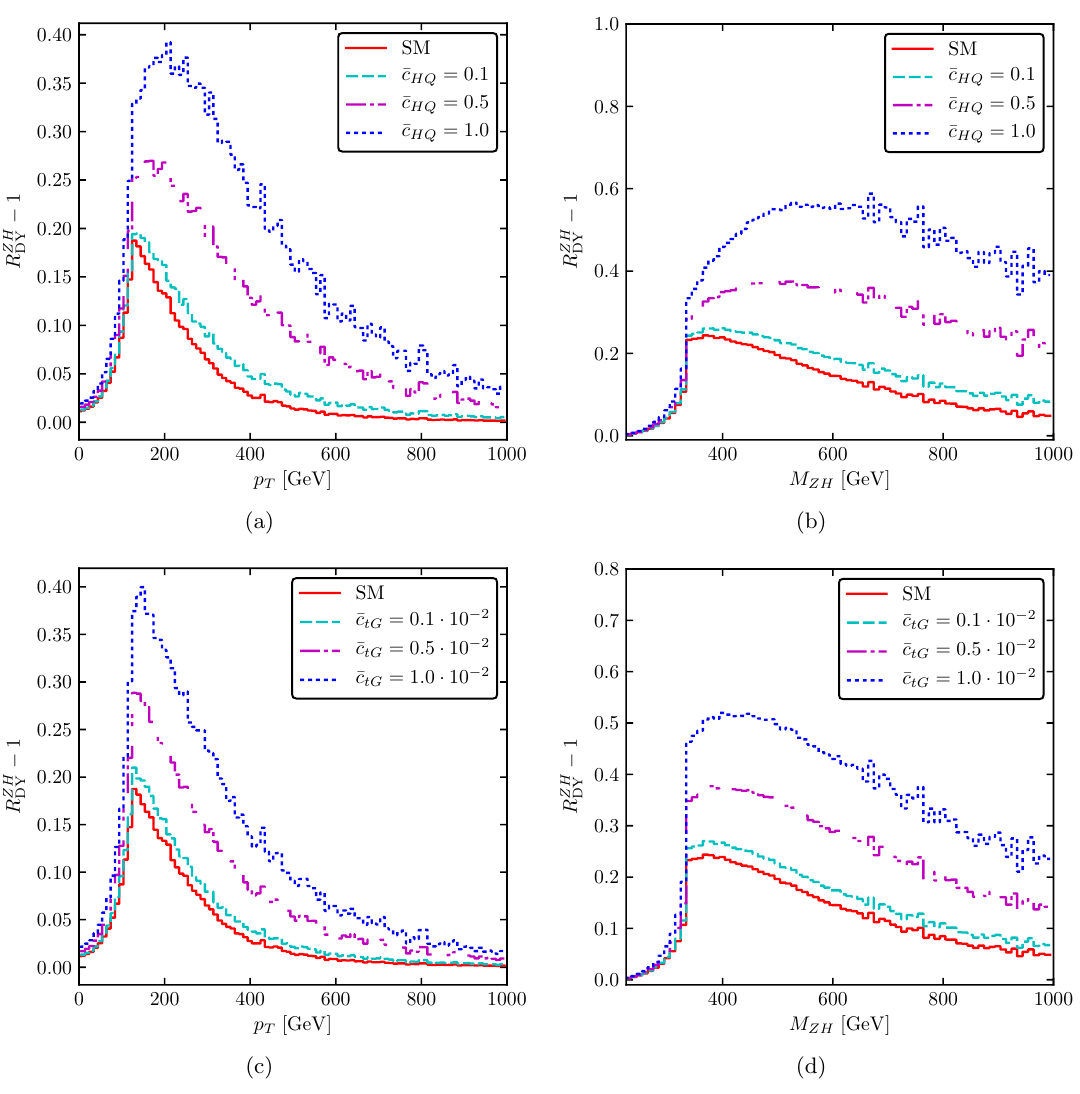
Figure 15 . Example of the impact of di(cid:11)erent dimension-6 operators on kinematic distributions while only including the interference term of the new operators and the SM